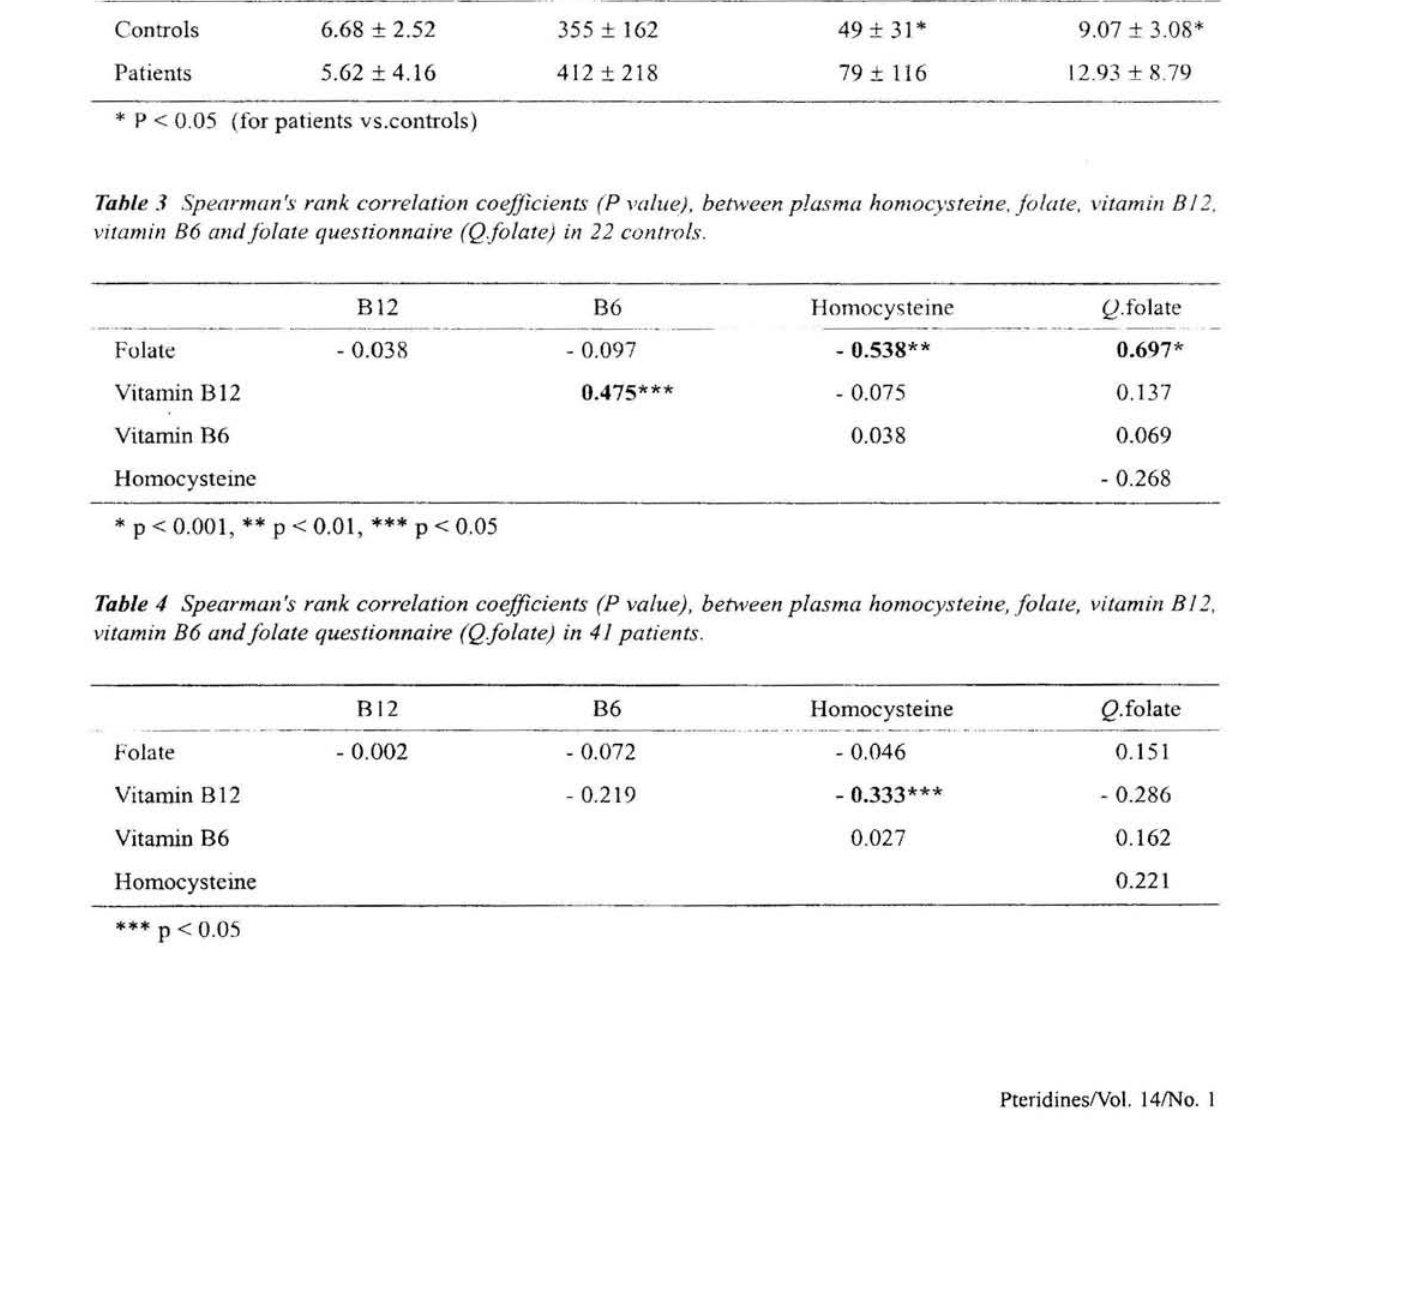
Table 2 Mean ±s.d. of serum folates, vitamin Bl2, vitamin B6. and plasma homcysteine for controls (n=22) and patients